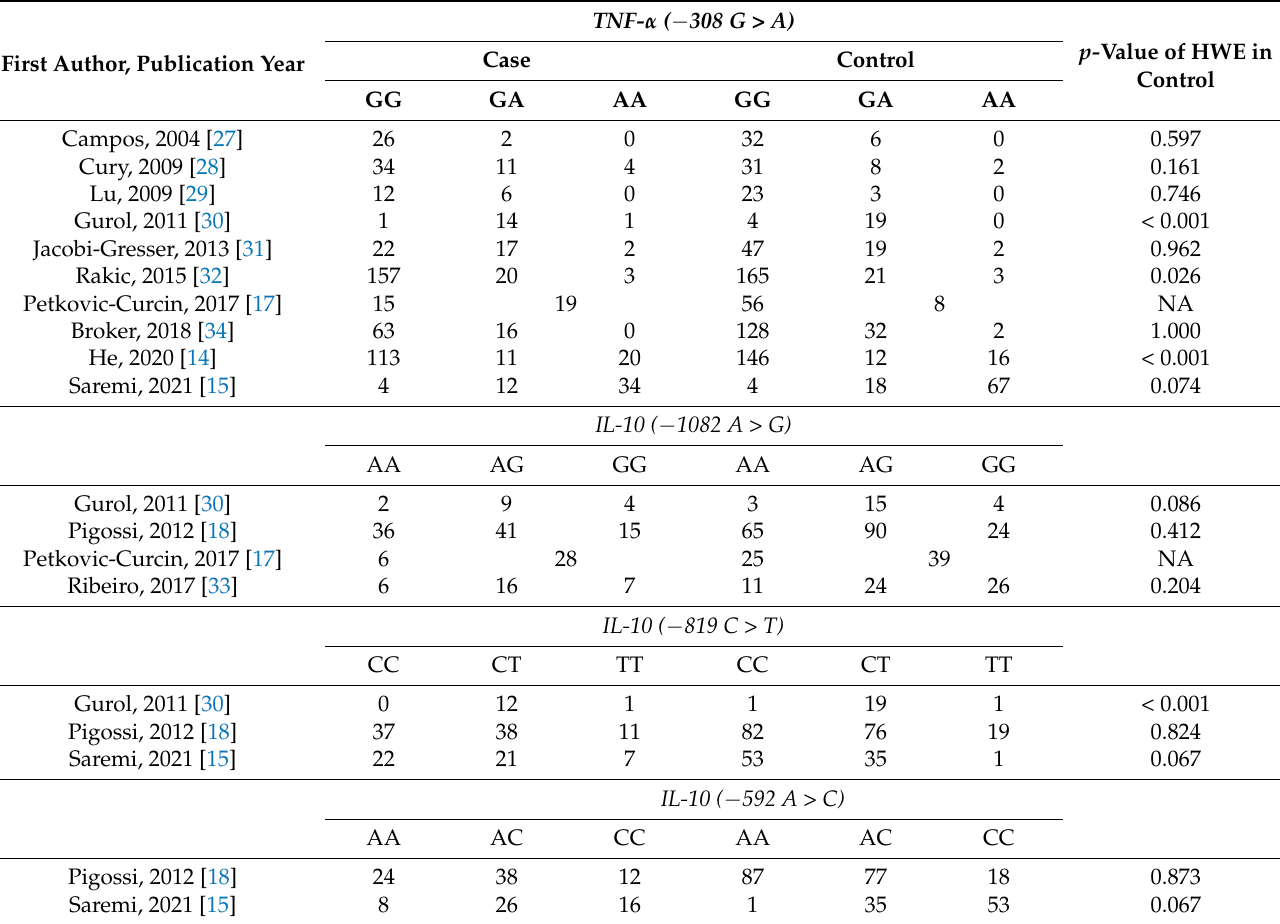
Table 2. Distribution of the genotypes of four